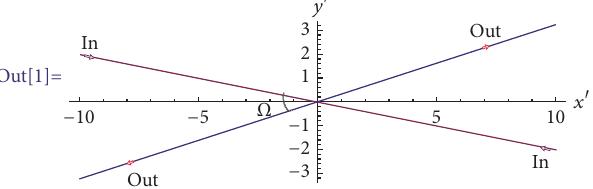
Figure1:Thepathofthetwopulsesforthecasesincoming( 𝑡 = −∞ ) and outgoing ( 𝑡 = ∞ ) corresponding to 𝑎 = 0.3 with the scattering angle